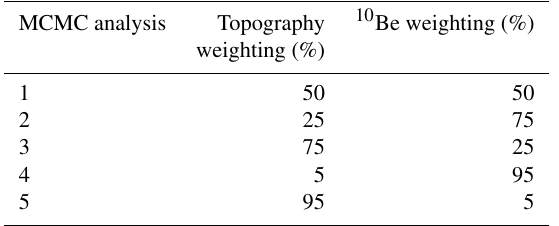
Table 1. Weightings assigned to the topographic and 10 Be concen- tration RMSE scores for the five MCMC calculations.